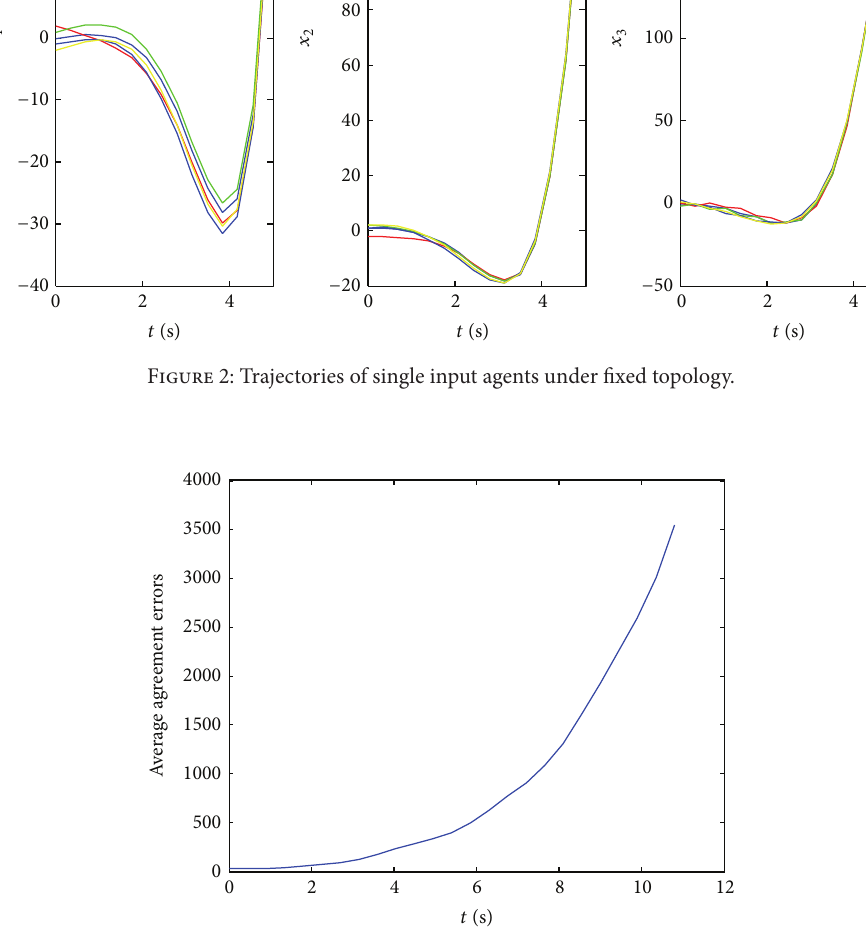
Figure 3: Average consensus errors with unallowable sampling